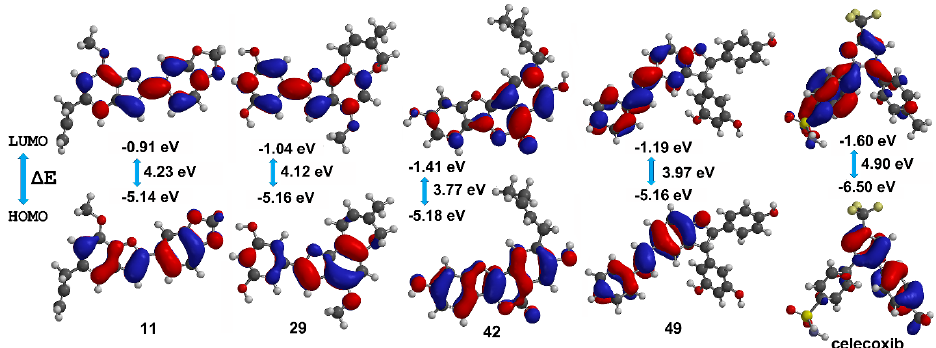
Figure 6. HOMO (highest occupied molecular orbital) and LUMO (lowest unoccupied molecular orbital) energies (in eV), HOMO-LUMO gaps ( ∆ E), and corresponding orbitals obtained by density functional theory (DFT) level for the best docked compounds ( 11 , 29 , 42 , 49 , and celecoxib (cel)).